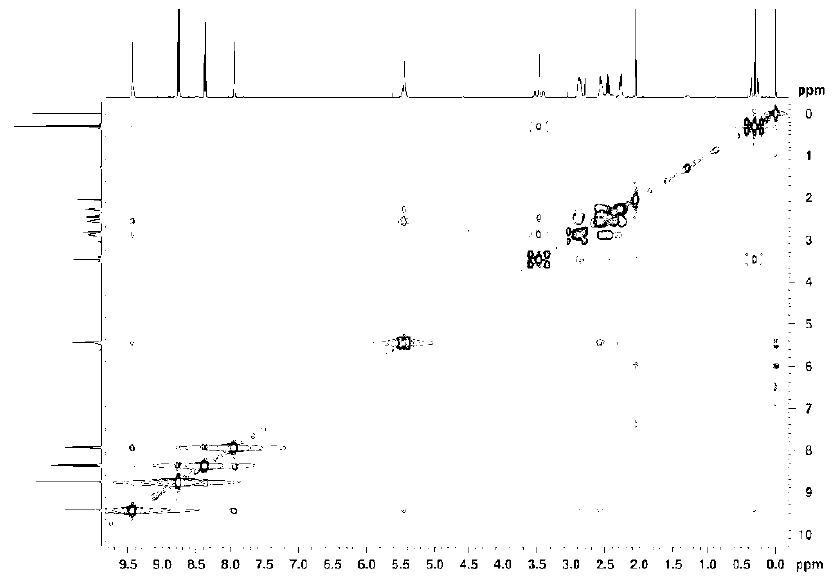
Figure 3. 1 H- 1 H NOESY spectra of [Pt(bpy)(cod)(Me)][SbF 6 ] in acetone-d 6 (600-ms mixing time at 600 MHz, 298